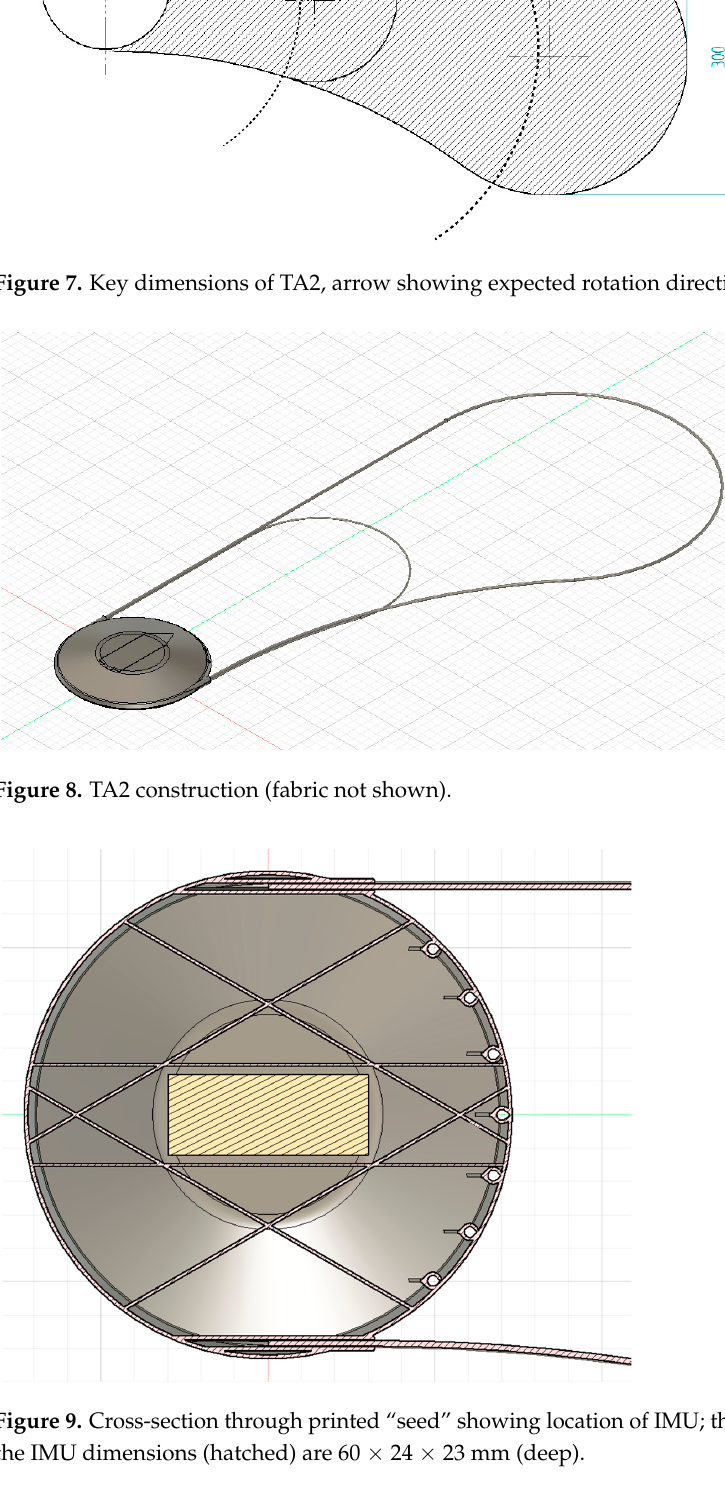
Figure 7. Key dimensions of TA2, arrow showing expected rotation direction.